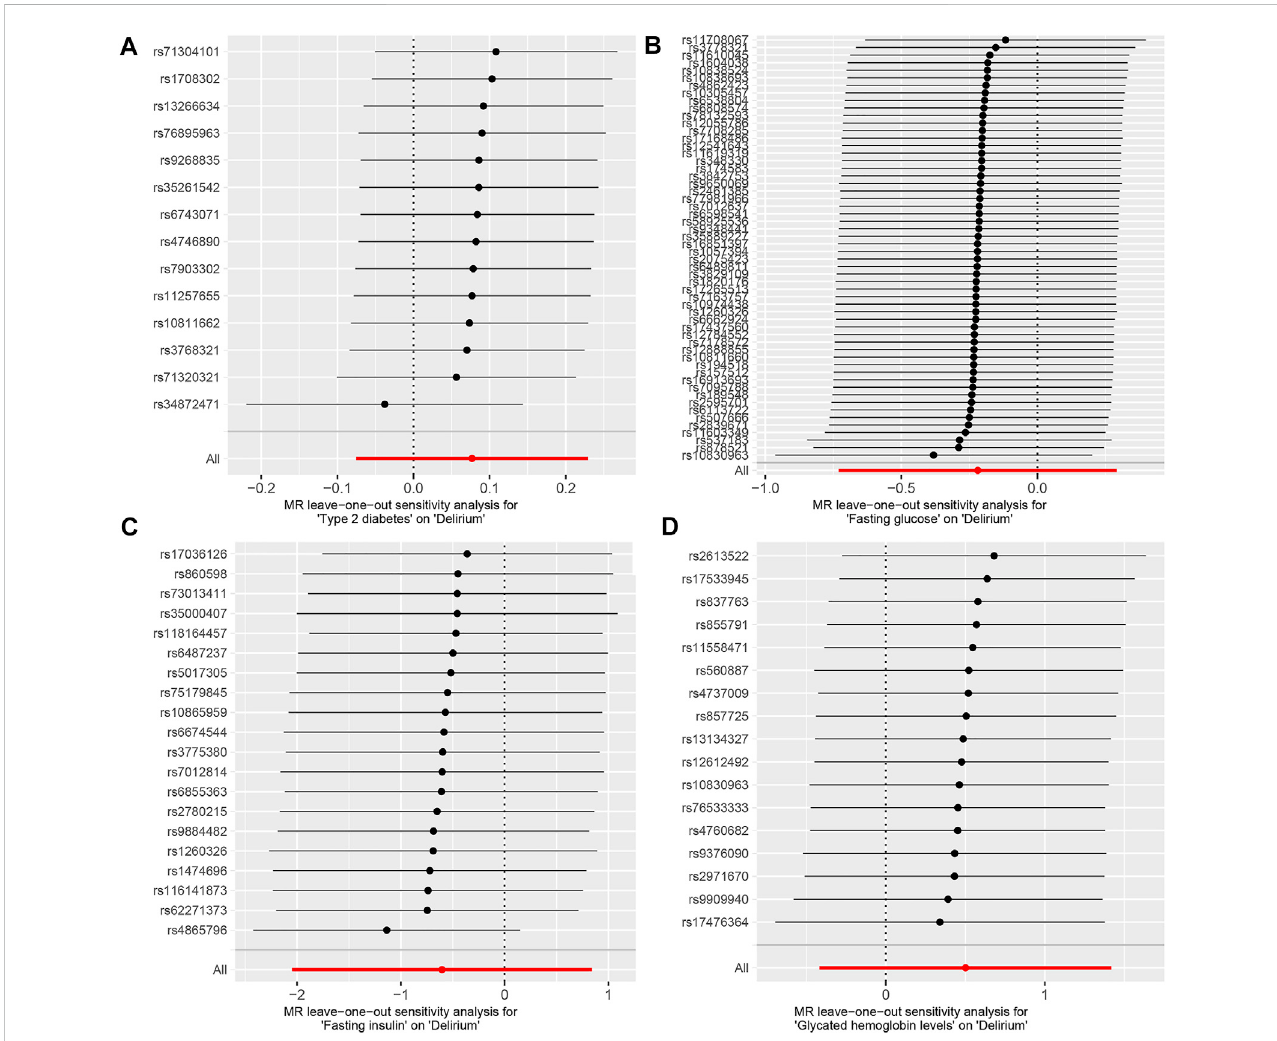
FIGURE 3 Leave one out analysis of the MR results between exposures and outcome. (A) T2D and delirium. (B) FG and delirium. (C) FI and delirium. (D) HbA1c and